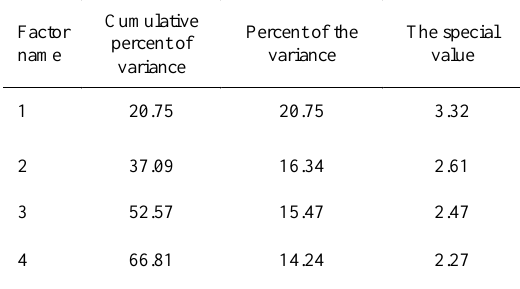
Table 3: The final extracted factors and their related specific amount